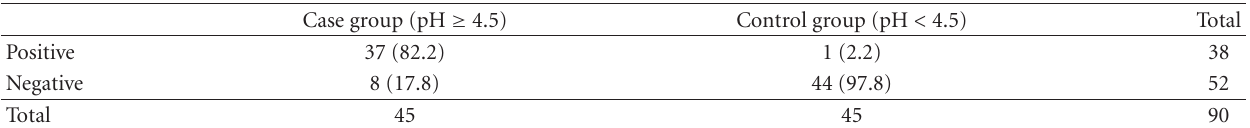
Table 2: Sensitivity and specificity of VS-SENSE test with pH less than 4.5 or more as discrimatie factors. Sensitivity: 82.2%, Specificity: 97.8%, Positive predictive value: 93.5%, and Negative predictive value: 93.4% (Bayes